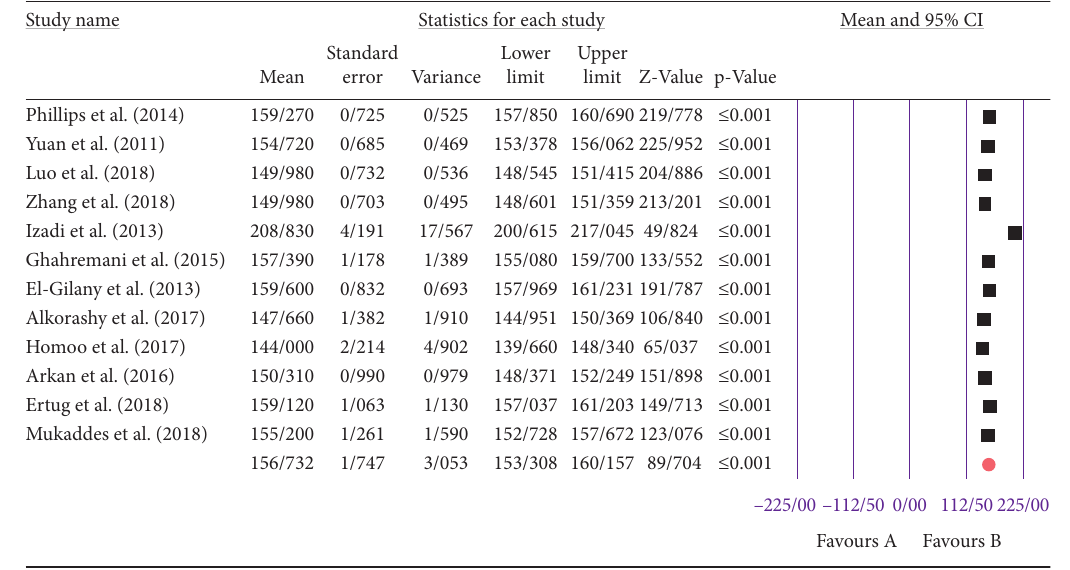
Figure 2: The overall mean score of self-directed learning in nursing